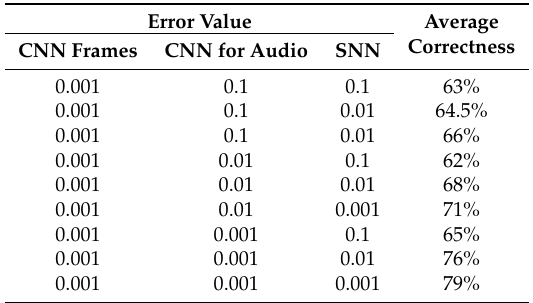
Table 3. Average correctness for various neural compositions applied for User 3.